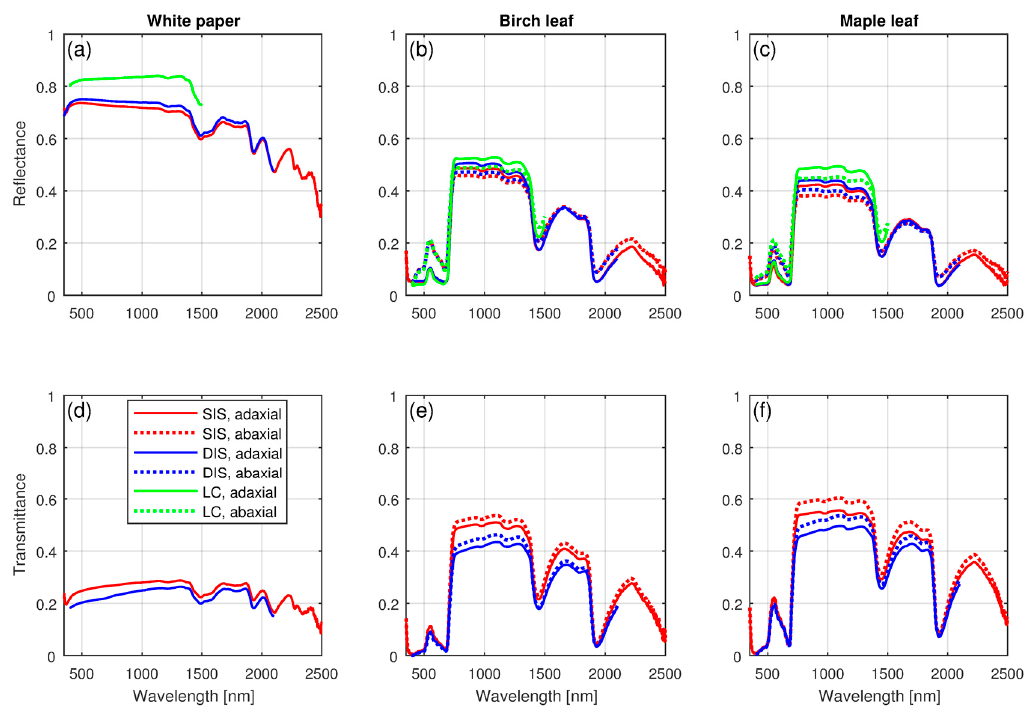
Figure 1. Mean reflectance and transmittance spectra of white paper, birch leaves, and maple leaves measured with different methods. SIS = single integrating sphere, DIS = double integrating sphere, LC = leaf clip. To avoid noisy regions due to low transmission of the fiber optic cables, spectra measured with DIS are presented only for 400–2100 nm, and those measured with LC for 400–1500 nm. Upper row ( a – c ): Reflectance; lower row ( d – f ): Transmittance.